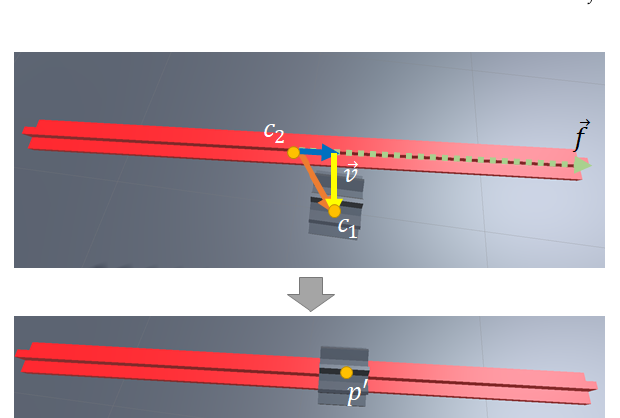
Figure 6. Calibration of